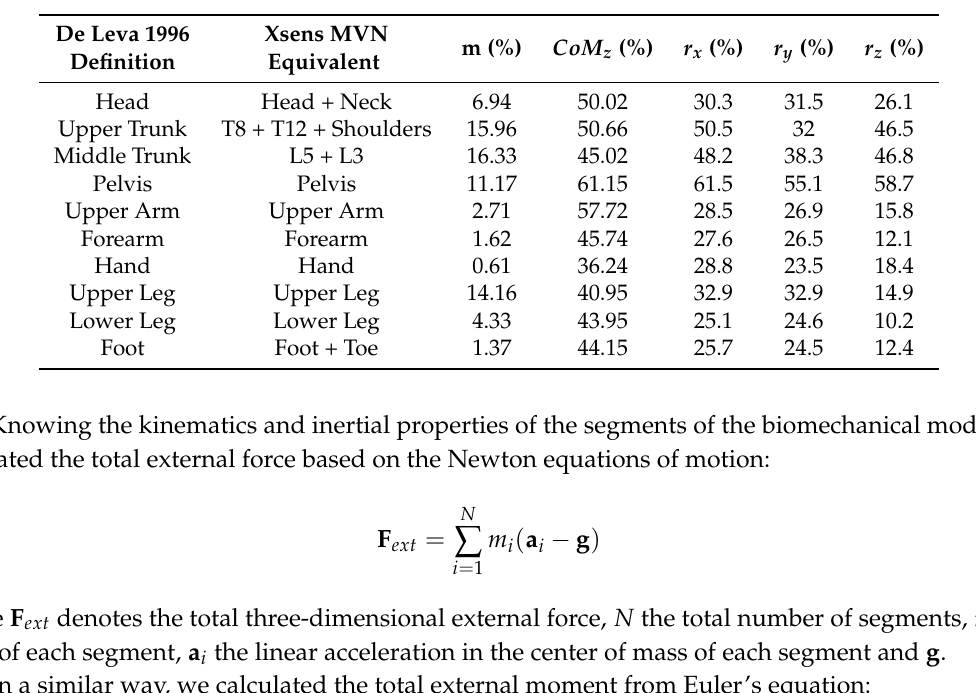
Table 1. Segments used in the 16-segment body biomechanical model, as described by De Leva [29], and the corresponding segments derived from the kinematic model of Xsens MVN Studio. The table includes the segment mass ratios (m), the longitudinal position of the center of mass in each